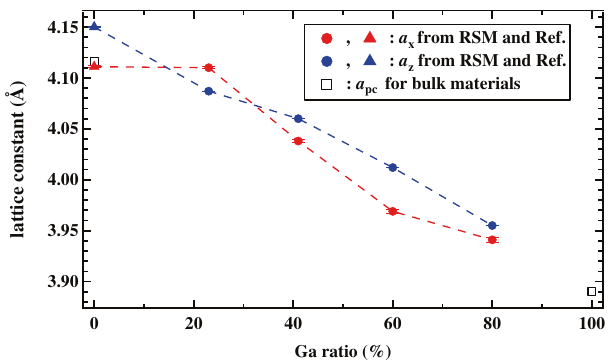
Fig. 5 In-plane lattice constant ( a x ) and out-of-plane lattice constant ( a z ) obtained from the RSMs. Values for LIO are from ref. 17 and shown as the triangular marks. a pc are the pseudocubic lattice constants from the bulk LIO and LGO. The small error bars represent the standard deviation in the Gaussian fi tting of the